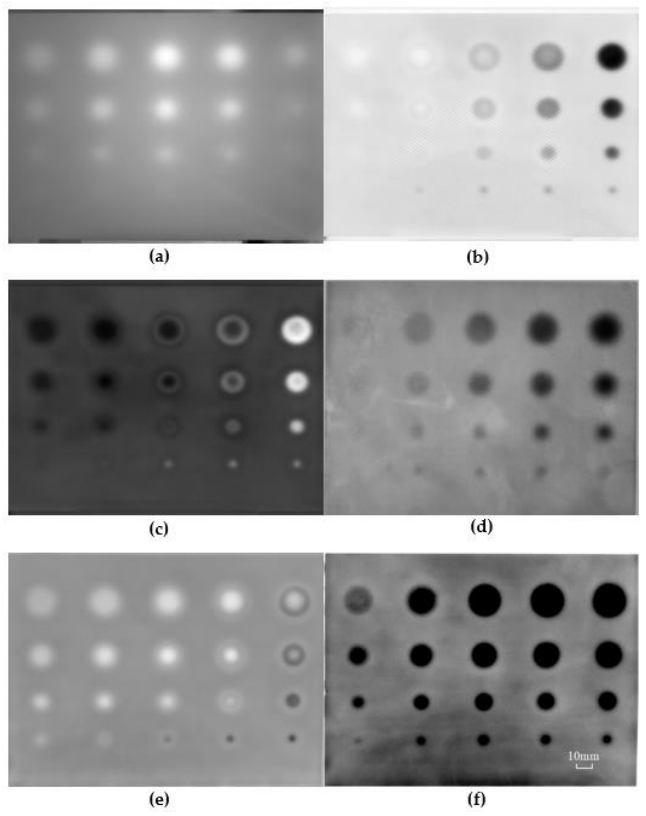
Figure 3. Detected images with varied methods in the GFRP panel. ( a ) Raw image; ( b ) thermographic signal reconstruction (TSR) + 1D, ( c ) TSR + 2D; ( d ) pulse phase thermography (PPT); ( e ) principal component analysis (PCA); ( f ) proposed method.